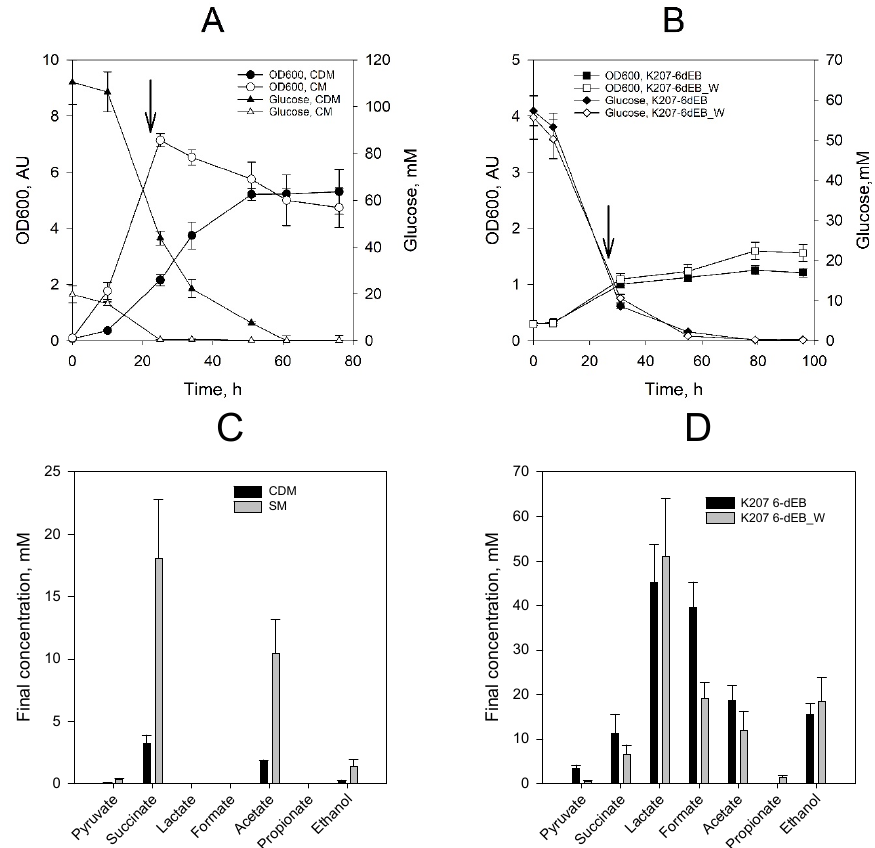
Figure 2. Batch cultures of E. coli K207-3 during the production of 6-dEB. ( A ) Aerobic fermentation performed in baffled flasks. The arrow indicates when the system was induced with IPTG (1 mM) and supplemented with propionate (10 mM). Complex SOC medium (SM) and chemically defined media (CDM). ( B ) Anaerobic fermentation performed in serum bottles in a chemically defined medium (CDM). The arrow indicates when the system was induced with IPTG (1 mM). All experiments were performed in duplicates. ( C ) Final fermentation products for aerobic cultures. ( D ) Final fermentation products for anaerobic